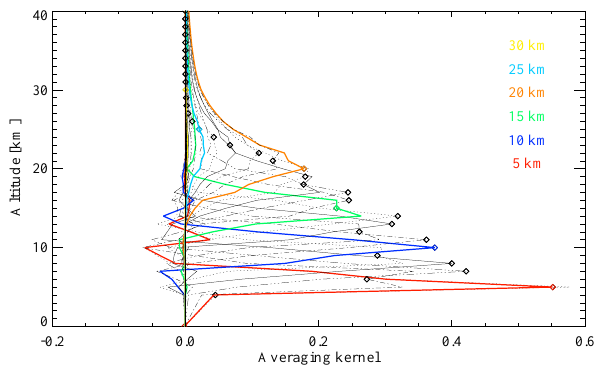
Fig. 7. As Fig. 1 but for PAN.